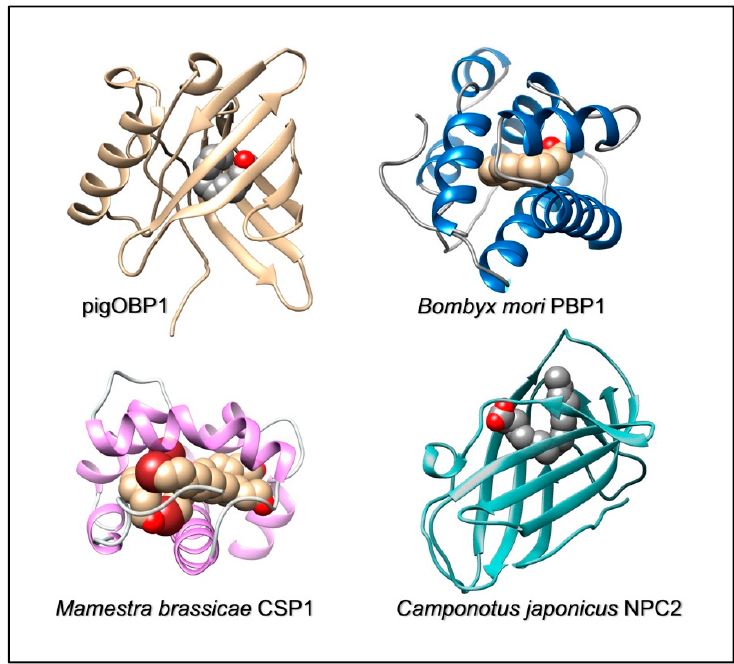
Figure 1. Three-dimensional structures of representative members of the four classes of soluble binding proteins so far described in chemical communication.